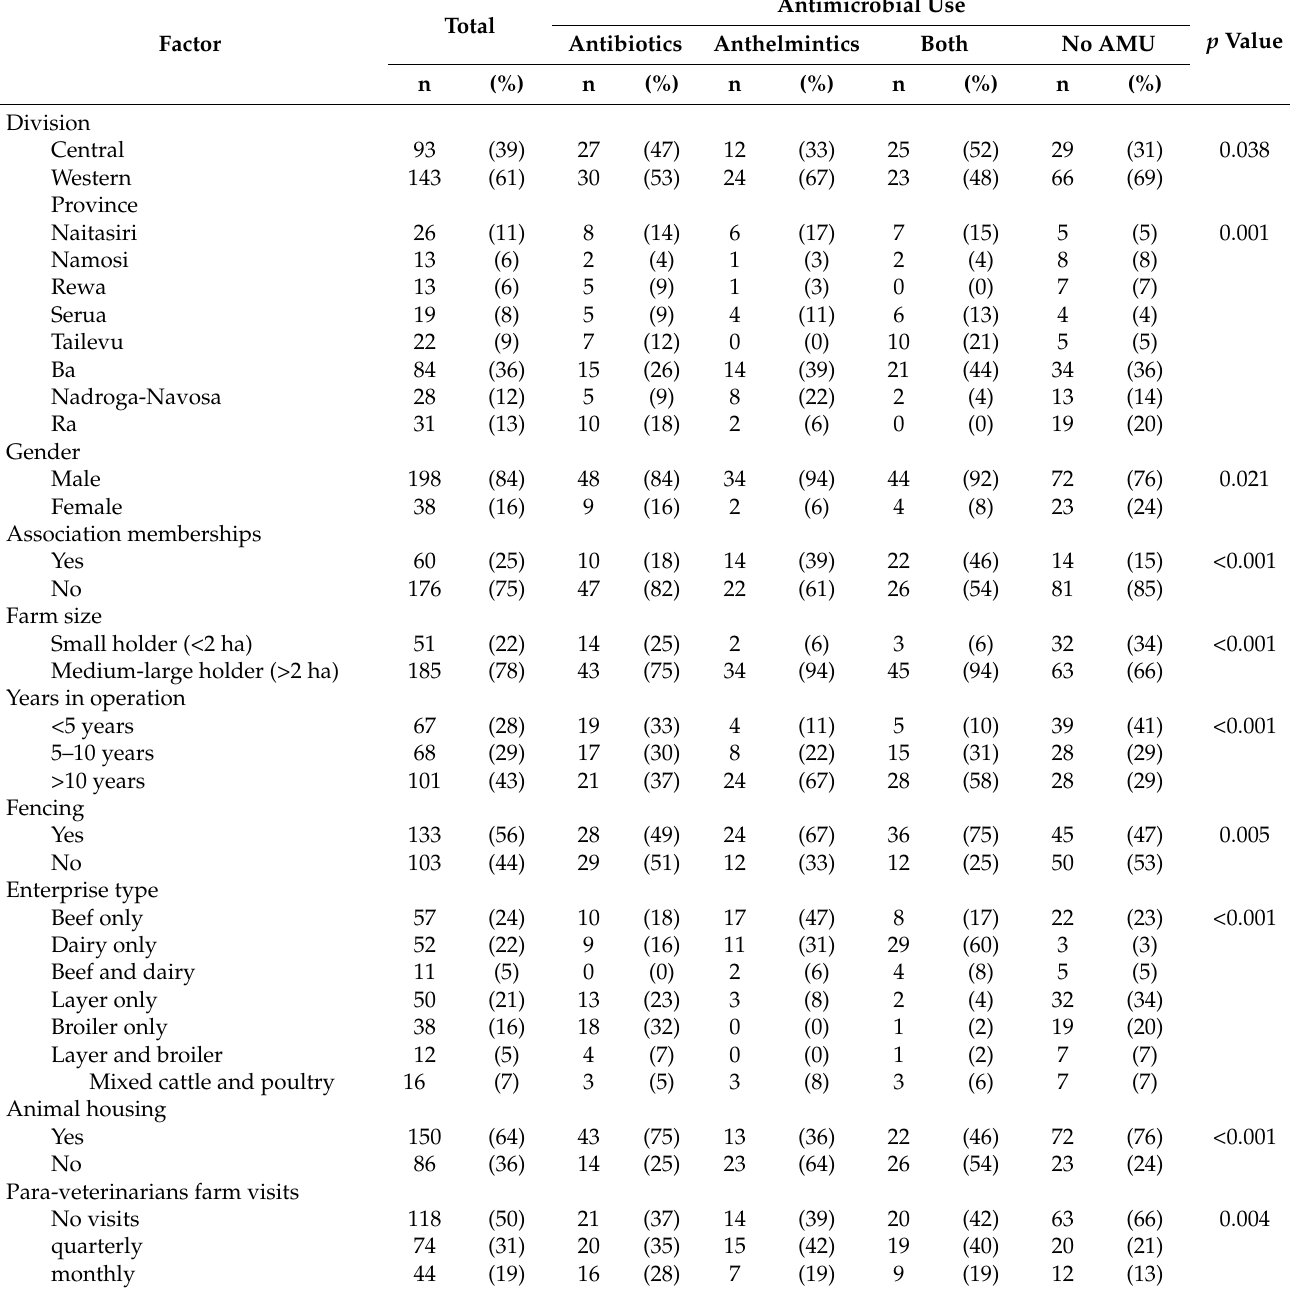
Table 1. Summary of associations between factors (farmer, livestock production and management) and antimicrobial use (antibiotics, anthelmintics, both and no antimicrobial use) on 236 livestock farms located in Central and Western divisions of Viti Levu,